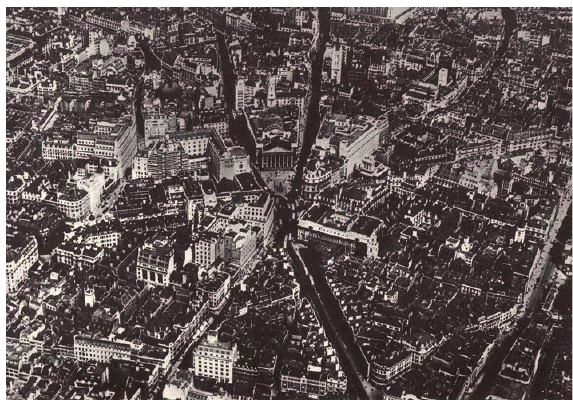
Fig. 7. Le Corbusier. Aircraft, (1935). Figure 102